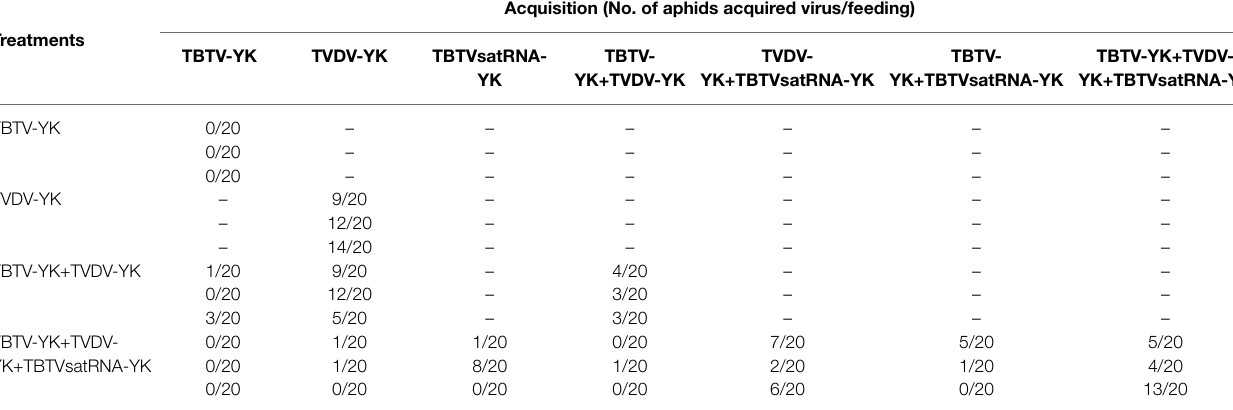
TABLE 1 | Acquisition efficiencies of TBTV-YK, TVDV-YK, and TBTVsatRNA-YK of TBTD by Myzus persicae .